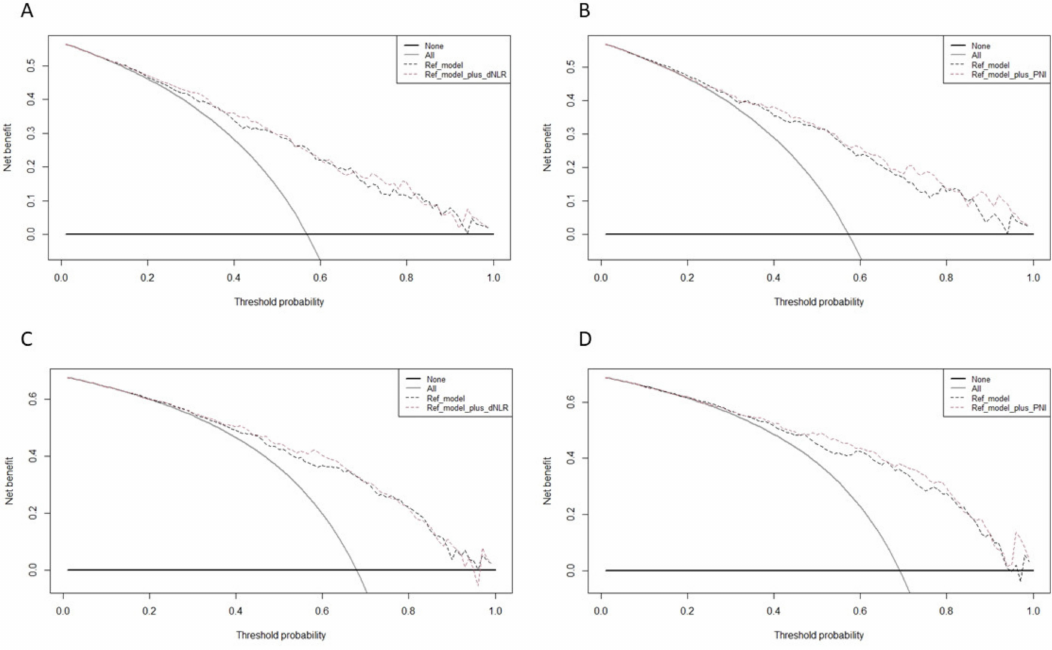
Figure 1. Decision curve analysis (DCA) for the net benefit of the pre-biopsy biomarkers based on the reference model for the prediction of ( A ) dNLR for GG ≥ 2, ( B ) PNI for GG ≥ 2, ( C ) dNLR for PCA, and ( D ) PNI for PCa. Decision